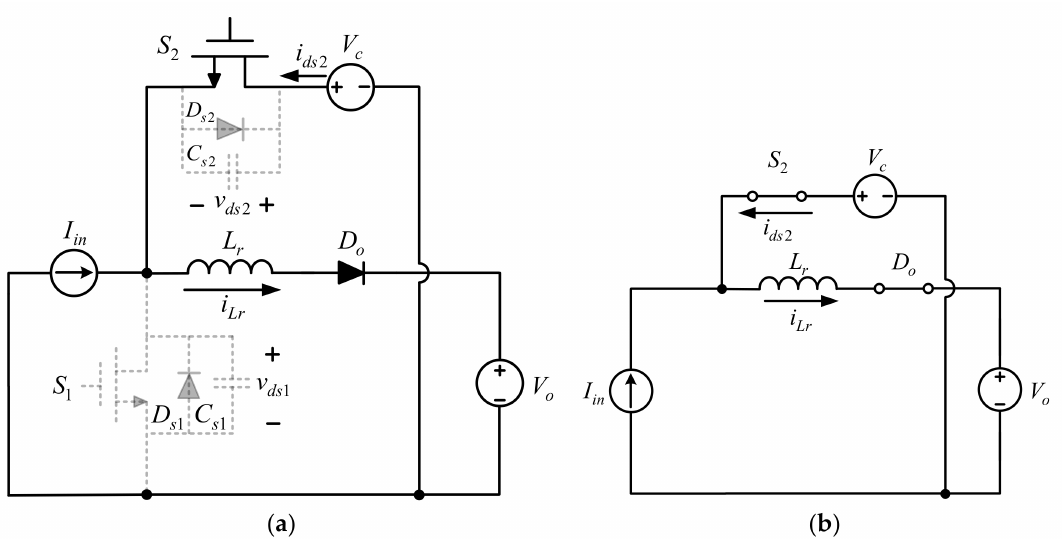
Figure 7. ( a ) Current path for stage 4; ( b ) equivalent of ( a ). Stage 5: ( t 4 ≤ t ≤ t 5 )